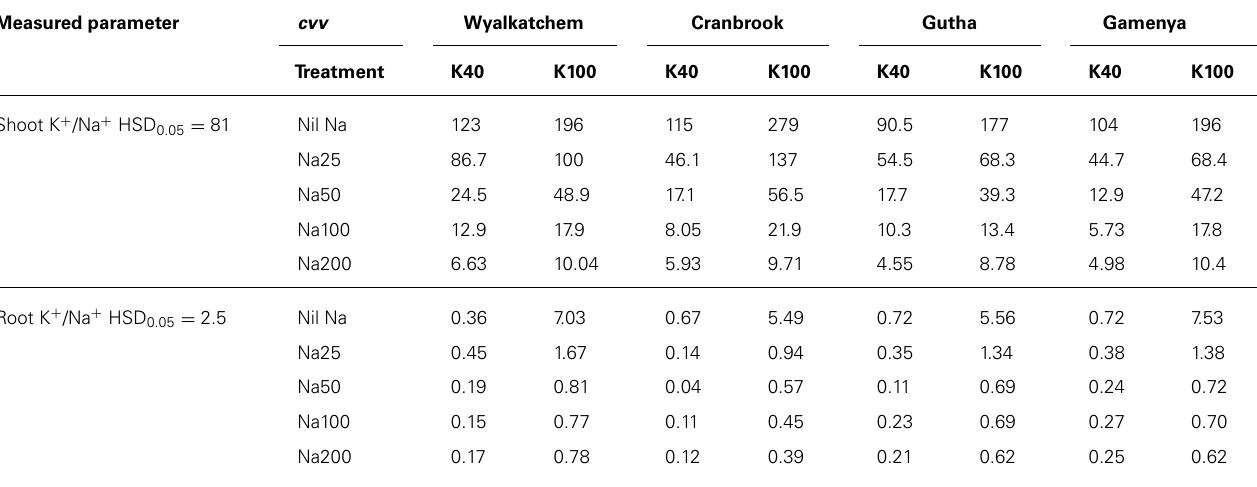
Table 4 | Shoot and root K + /Na + ratios of four wheat cultivars treated with two K levels (40, 100 mg K/kg) and five Na levels (0, 25, 50, 100, 200 mg Na/kg) for 8 weeks ( n = 3). Measured